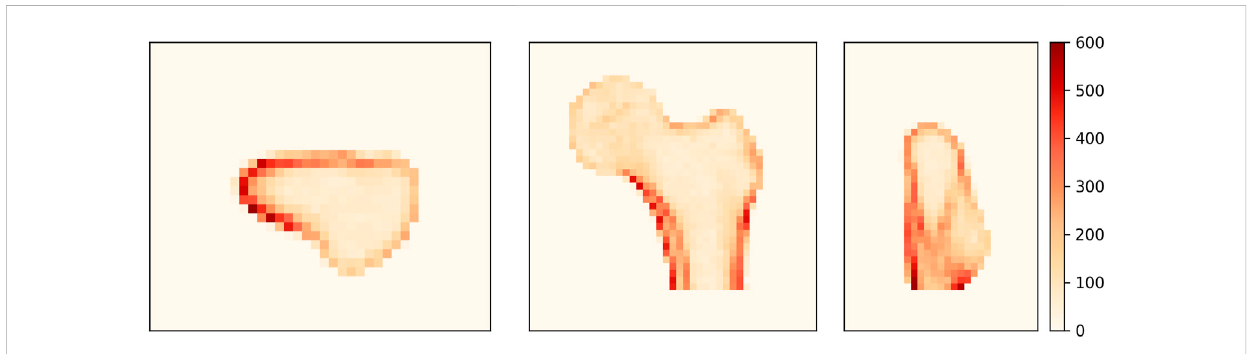
FIGURE 7 Average unsigned BMD difference between CT and 3D DXA (mg/cm 3 ) shown on an axial (left), a coronal (center) and a sagittal (right) plane of the standard femur.